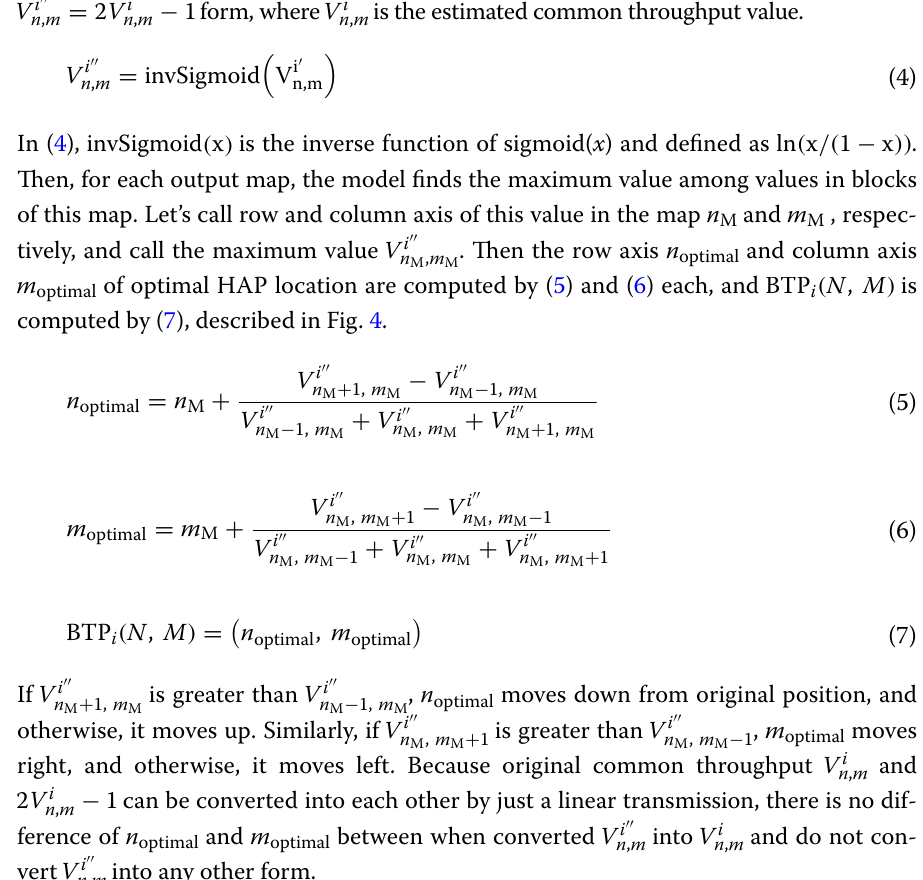
Figure 5 is the flow chart for our experiment. For each estimated optimal HAP placement point for each test map BTP i ( N , M )